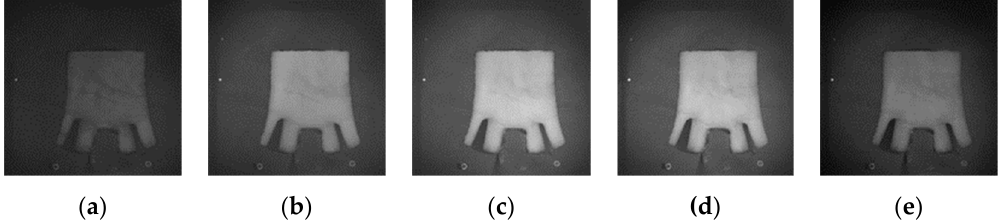
Figure 7. Hyperspectral palm vein (HPV) samples from different spectra. ( a ) 560 nm; ( b ) 660 nm; ( c ) 760 nm; ( d ) 860 nm; ( e ) 960 nm.